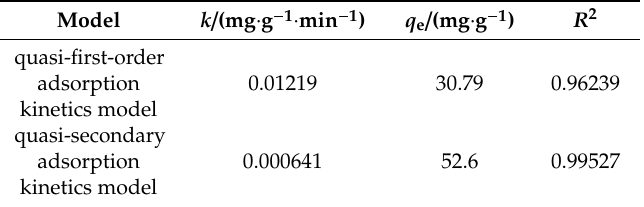
Table 3. Results of CS / GO aerogel adsorption kinetics model fitting.